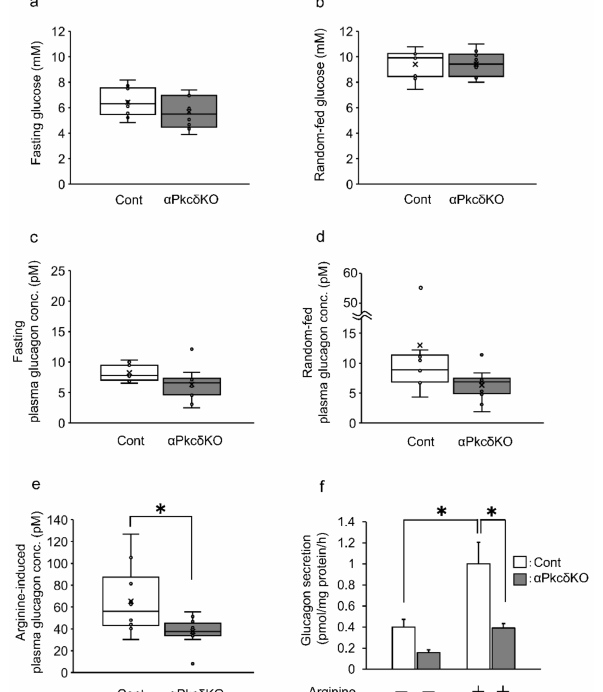
Figure 4. Arginine-induced glucagon secretion decreased in α Pkc δ KO mice and the islets